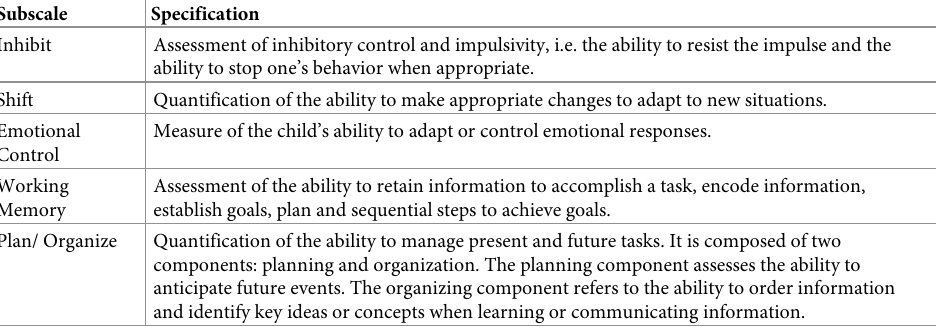
Table 1. Subscales of executive function quantified from the BRIEF-P: Inhibit shift, emotional control working memory, and plan/organize.